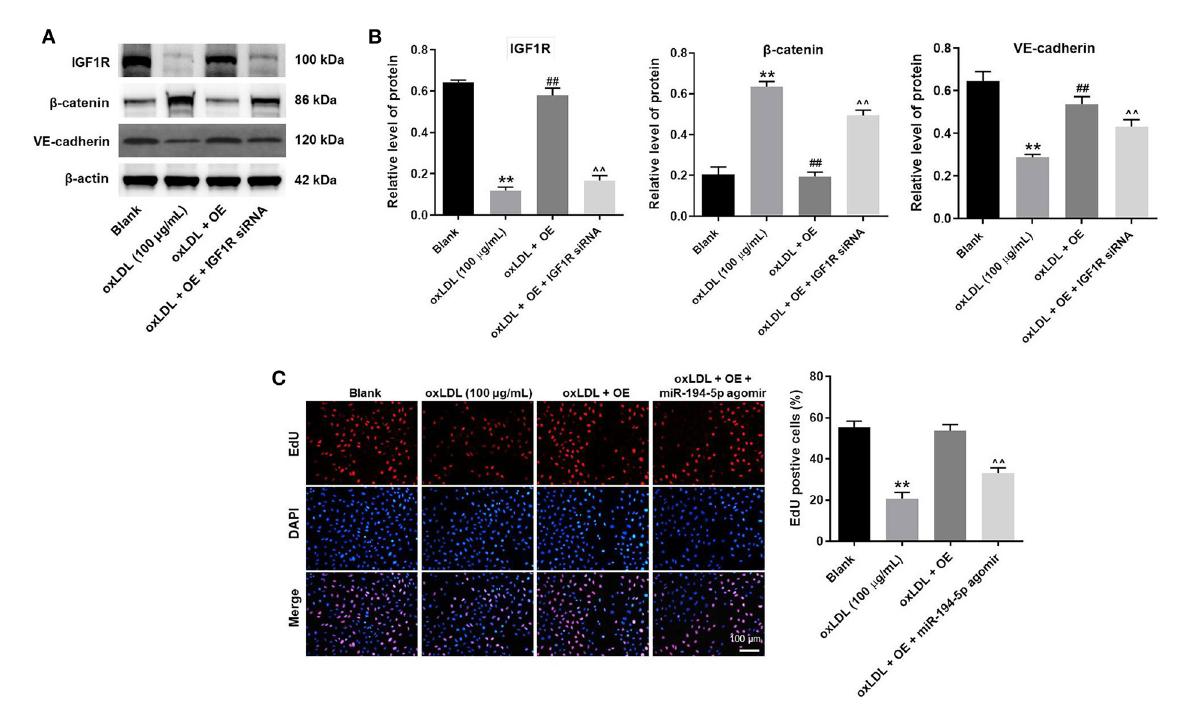
FIGURE6 LINC00452 overexpression reverses oxLDL-induced HUVEC growth inhibition via regulating miR-194-5p/IGF1R pathway. (A) Western blot assay was performed to detect the expressions of IGF1R, β -catenin and VE-cadherin. (B) β -actin was used for normalization. (C) EdU assay was performed to detect the proliferation of HUVECs. ** P < 0.01 compared to control group. ## P < 0.01 compared to oxLDL (100 µ g/mL) group. ∧∧ P < 0.01 compared to oxLDL + LINC00452 OE group, n =